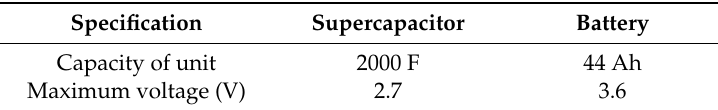
Table 1. Unit parameters.